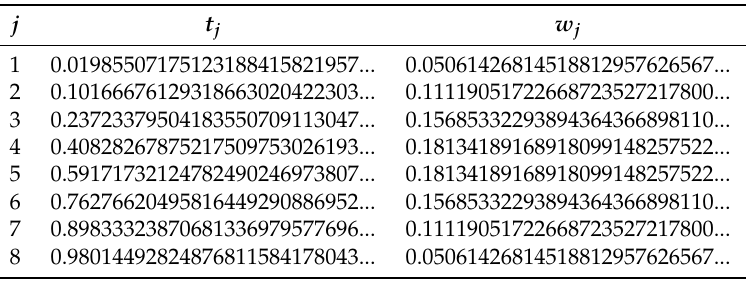
Table 4. Abscissas and weights of Gauss-Legendre quadrature formula.